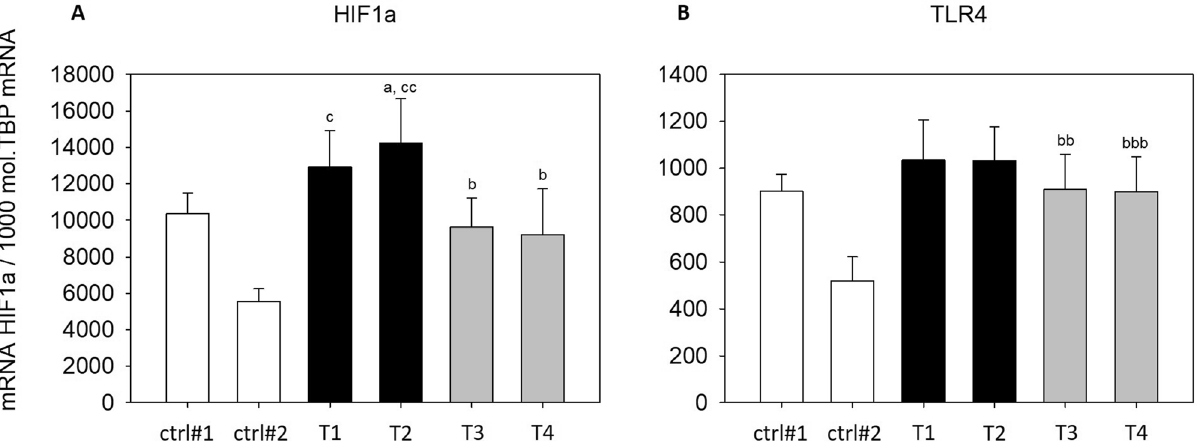
Figure 9. mRNA expression of HIF1α ( A ) and TLR4 ( B ) in THP-1 cells incubated with SGBS-CM. THP-1 cells were incubated for 4 days with SGBS-CM from d4 (T1 or T2) and d8 (T3 or T4) of adipogenesis. The corresponding controls were ctrl#1: RPMI + unconditioned induction medium from d4 (1:1) and ctrl#2: RPMI + unconditioned differentiation medium from d8 (1:1). For qRT-PCR, mRNA samples of THP-1 macrophages were taken at d7 of differentiation. The TATA-Box binding protein ( TBP ) was used as a housekeeping gene. The data were statistically analyzed by one-way ANOVA on ranks with the Student–Newman–Keuls method. N = 6, n = 1 (4 pooled wells); *p < 0.05, DEHP vs. DMSO at d4 or d8; a p < 0.05, aa p < 0.01, aaa p < 0.001, THP-1 + SGBS-CM [d4] vs. ctrl#1 or ctrl#2; b p < 0.05, bb p < 0.01, bbb p < 0.001, THP-1 + SGBS-CM [d4] vs. [d8].